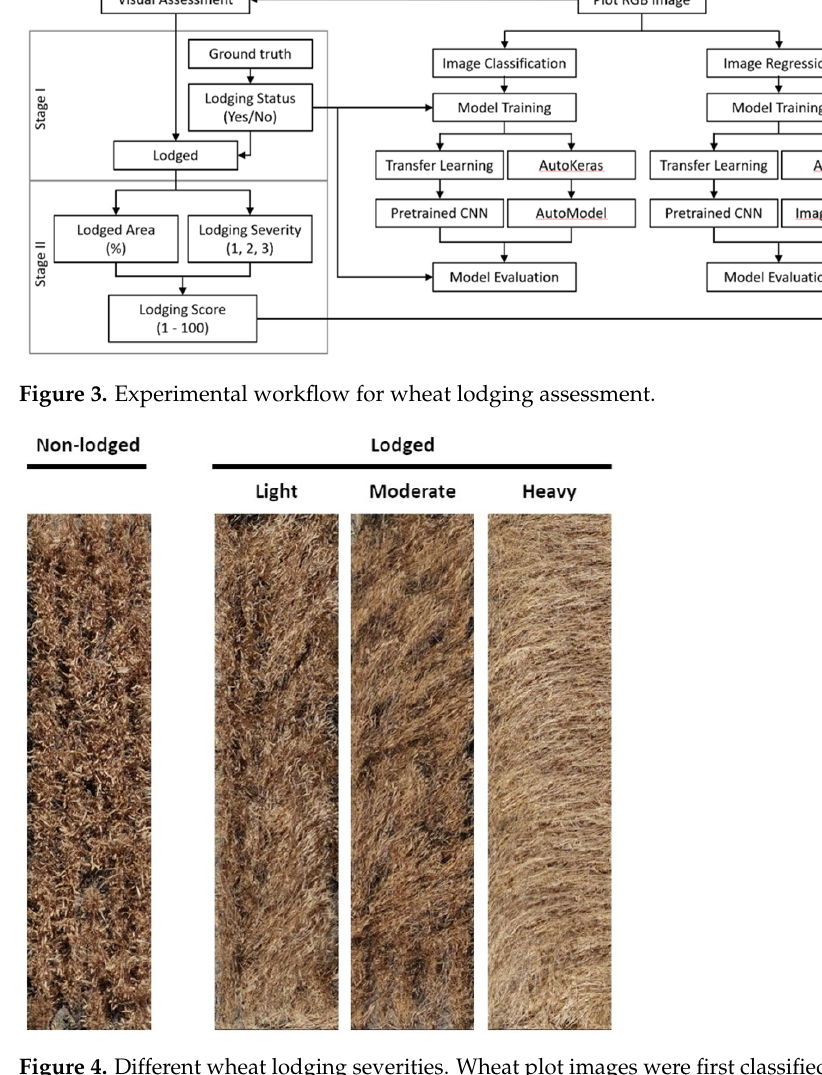
Figure 4. Different wheat lodging severities. Wheat plot images were first classified as non-lodged or lodged using ground-truth data. Plots identified as lodged were assessed visually and divided into three lodging severities (light, moderate, and heavy) based on lodging angles.